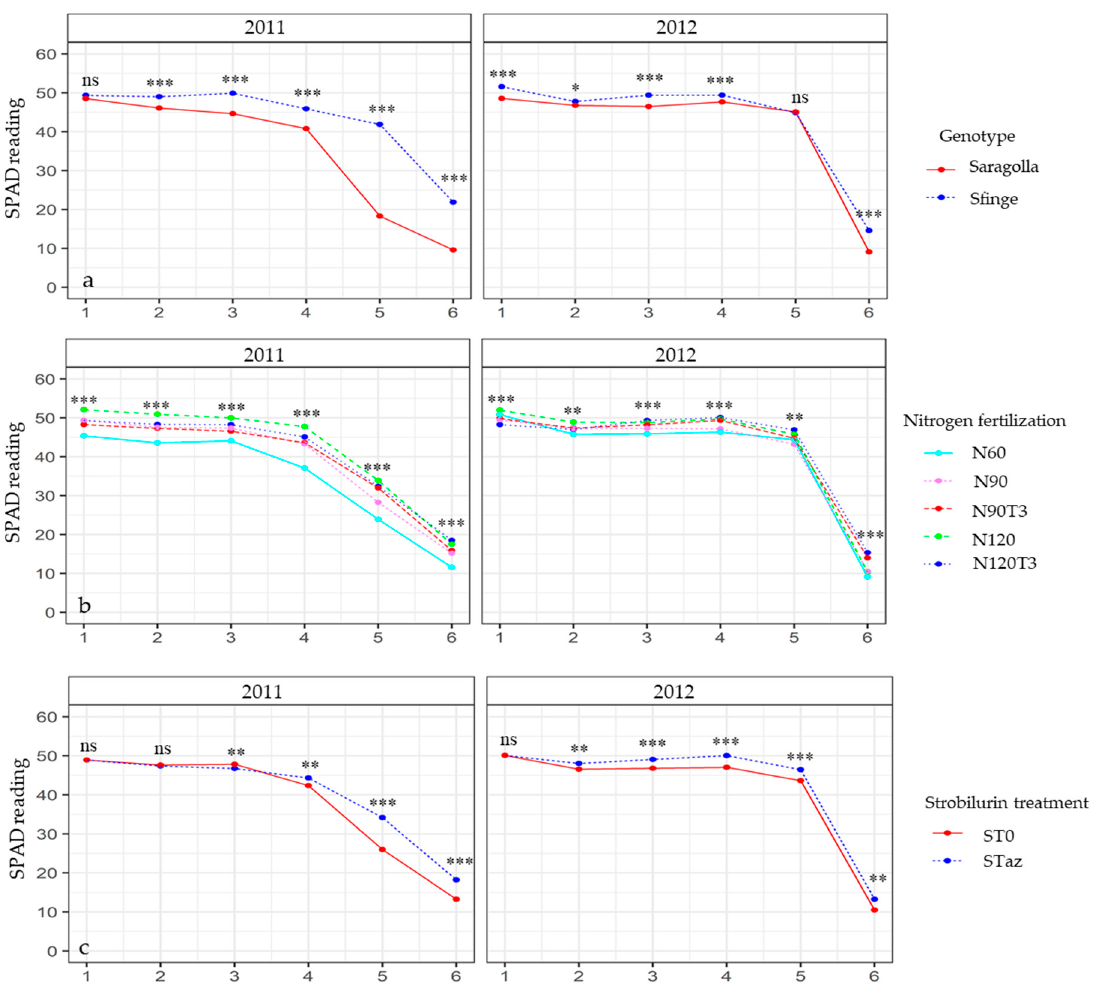
Figure 1. Effect of cultivar ( a ), nitrogen fertilization ( b ) and strobilurin treatment ( c ) on SPAD readings during the two growing seasons (2011 and 2012) from stem elongation to soft-ripening. 1 = SPAD1 (BBCH 31–39). 2 = SPAD2 (BBCH 41); 3 = SPAD3 (BBCH 53–59); 4 = SPAD4 (BBCH 63–67); 5 = SPAD5 (BBCH 72–78); 6 = SPAD6 (BBCH 80–86) [24]. N60, N90 and N120 correspond to 60, 90 and 120 kg ha − 1 of nitrogen applied two times; N90T3, 90 kg ha − 1 of nitrogen applied three times; N120T3, 120 kg ha − 1 of nitrogen applied three times. ST0, no strobilurin treatment; STaz, strobilurin treatment. **, significant at p ≤ 0.01, ***, significant at p ≤ 0.001; ns, not significant.